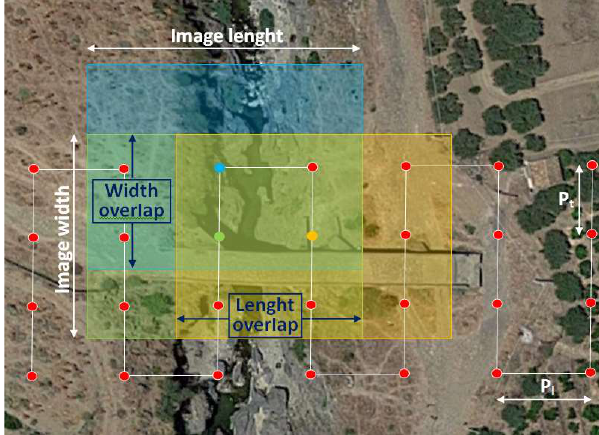
Figure 3. Waypoint and overlap in RGVC at h v = 40 m.